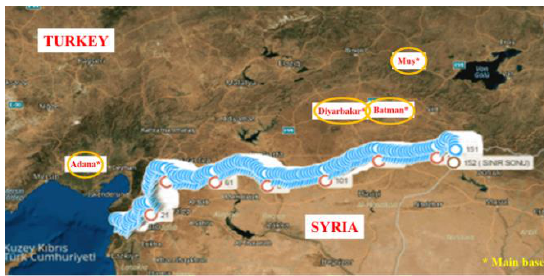
Figure 8. The selected 152 grid points and 4 main bases (Adana, Diyarbakır, Batman, and Muş).